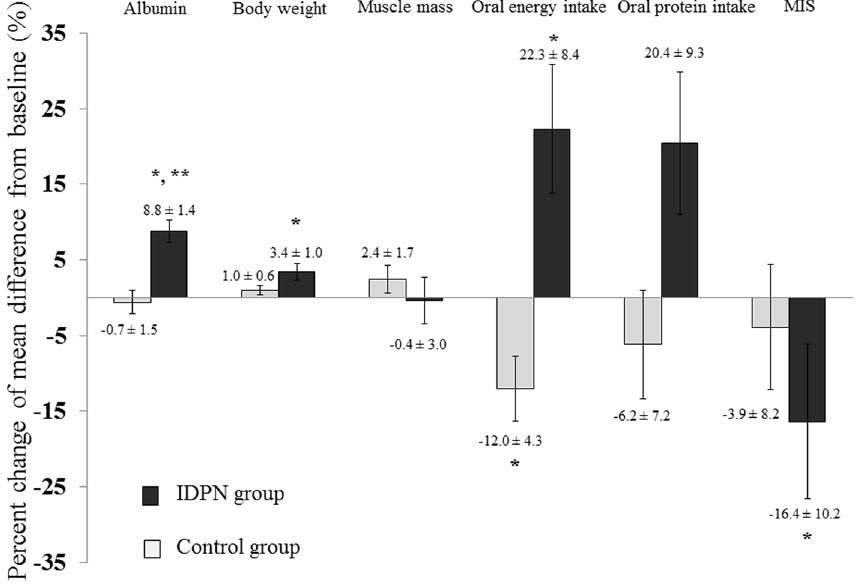
Figure 3. Mean percentage changes of multi-dimensional nutritional assessment according to protein- energy wasting (PEW) criteria including serum albumin as biochemical parameter, body weight as body mass criterion, total-body muscle mass, dietary intake and MIS as an alternative tool after intervention in the IDPN compared with the control group. Data are shown as mean ± standard error of mean (SEM). Percentage change = [(3 months follow up − baseline values)/baseline values] × 100. * denotes p < 0.05 after 3 months of IDPN treatment. ** indicates p < 0.01 between groups comparison at 3 months.